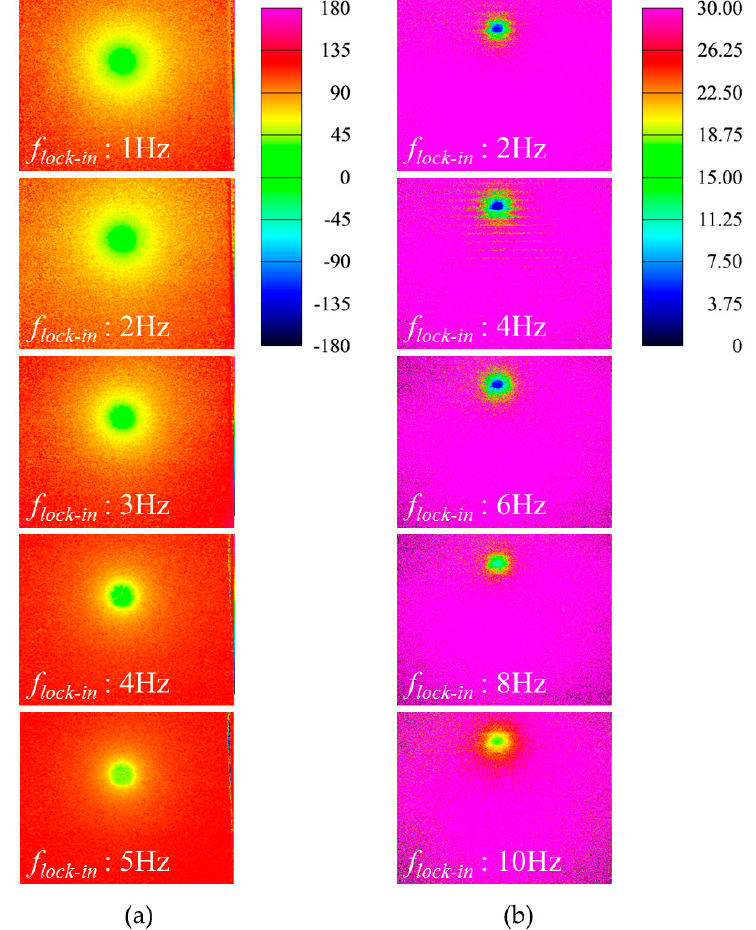
Figure 6. Phase images of SSHSCs for various lock-in frequencies with 4 voltage bias input: ( a ) two-layer SSHSC; ( b ) three-layer SSHSC. ( a ) two-layer SSHSC; ( b ) three-layer